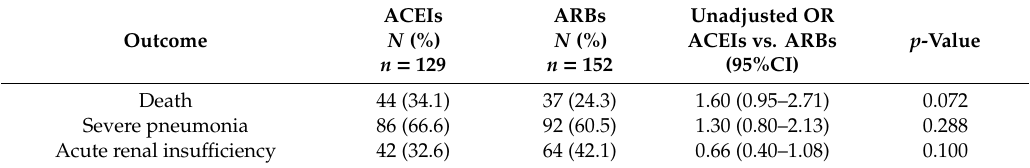
Table 4. Univariate analysis of outcomes according to RASi pharmacological class (ACEIs versus ARBs). Unadjusted OR ARBs ACEIs p -Value N (%) N (%) ACEIs vs. ARBs Outcome n = 152 n = 129 (95%CI) Death 44 (34.1) 37 (24.3) 1.60 (0.95–2.71) 0.072 Severe pneumonia 86 (66.6) 92 (60.5) 1.30 (0.80–2.13) 0.288 Acute renal insu ffi ciency 42 (32.6) 64